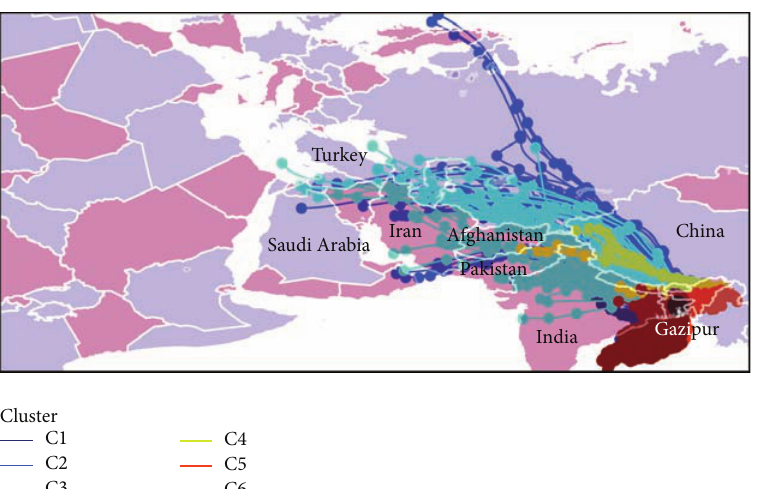
Figure 4: 96-hour HYSPLIT back trajectories centered on Gazipur station during dry season grouped as cluster and colored accordingly.